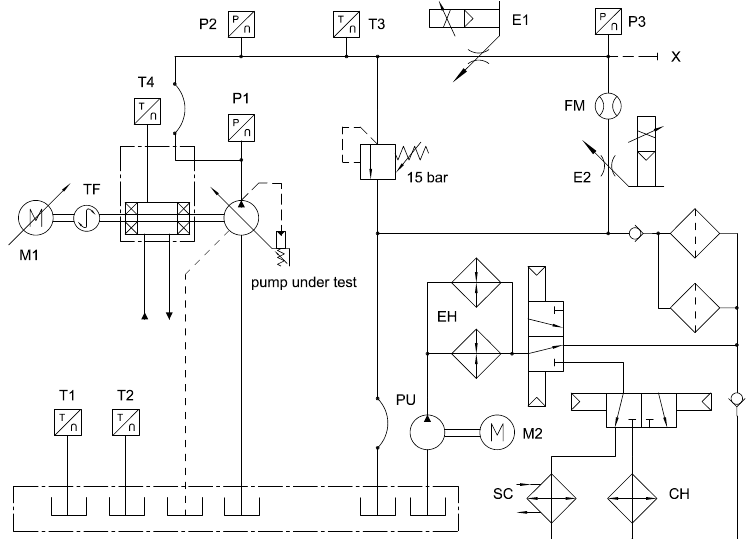
Figure 4. Hydraulic scheme of the test rig for the model validation.